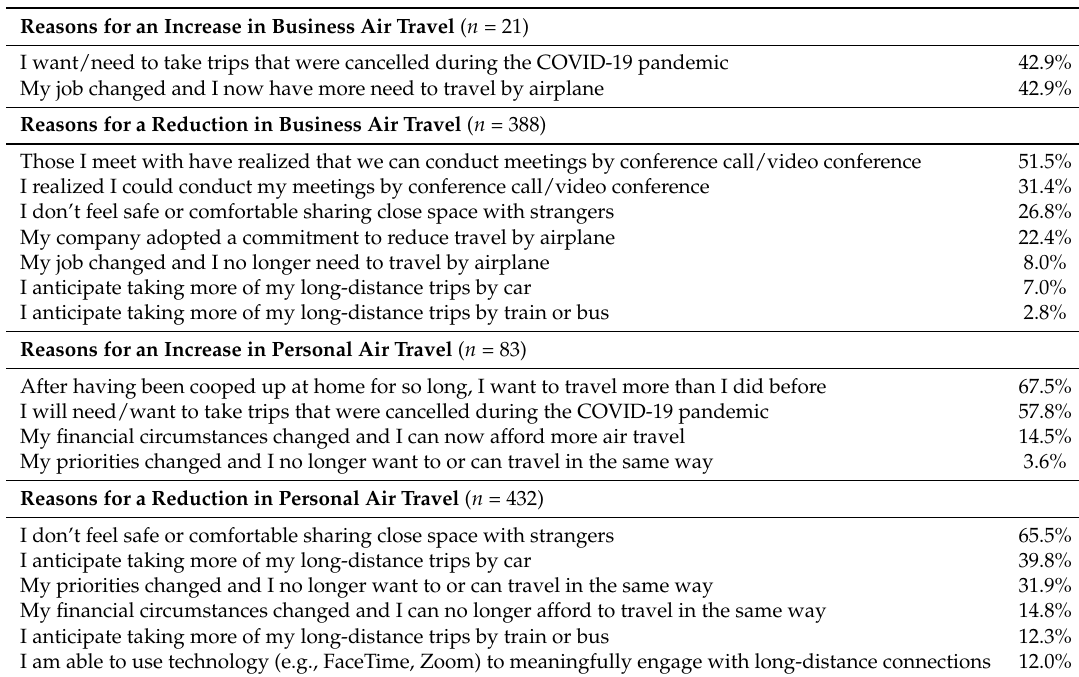
Table 4. Percent of respondents reporting a change in their air travel selecting particular reasons for that